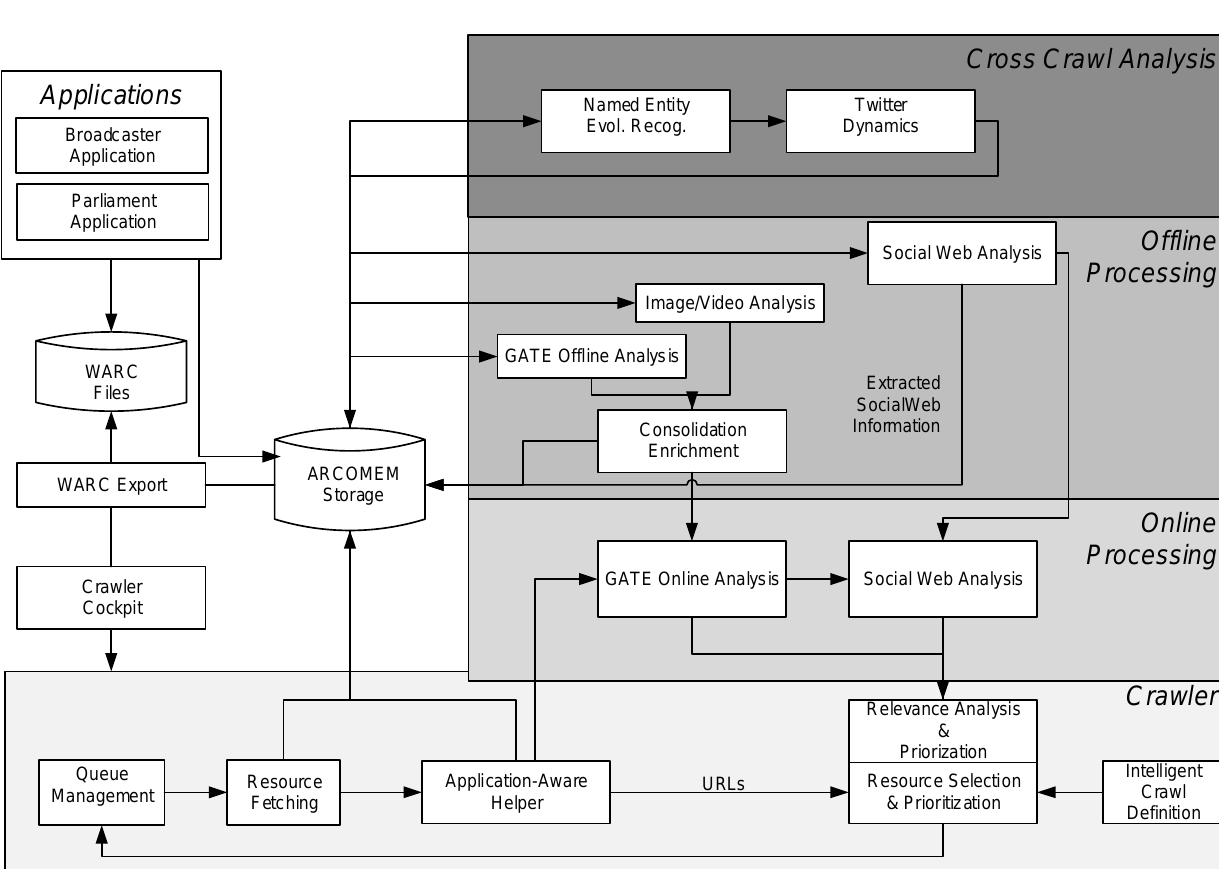
Figure 2. Overall